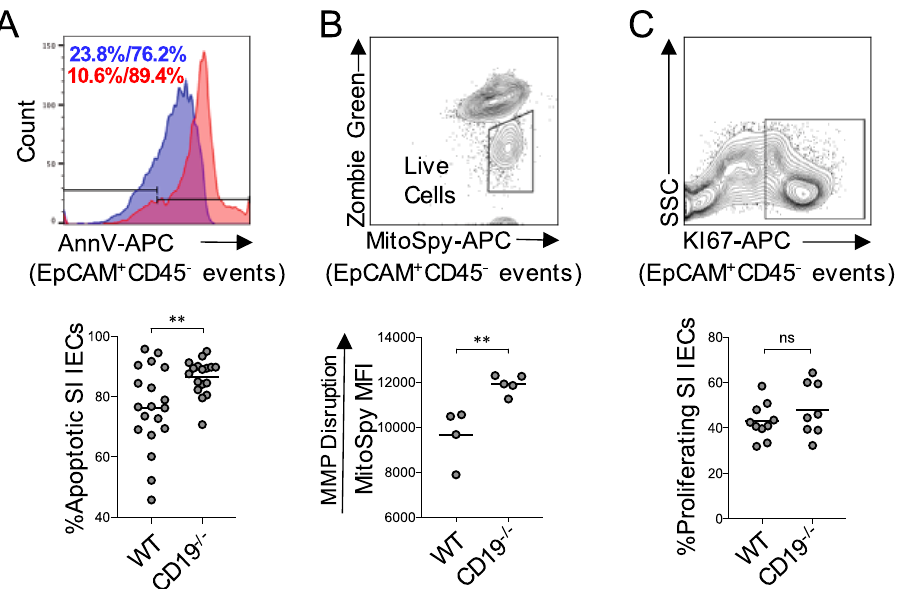
Fig. 3 SI enteropathy is associated with increased IEC apoptosis in CD19 − / − mice. A Representative fl ow cytometry plot demonstrating gating on apoptotic IECs (EpCAM + CD45 − PI − AnnV + ) and the percentage of apoptotic IECs in WT and CD19 − / − mice are shown. Two-tailed unpaired Student ’ s t-test; ** = p = 0.007. Data representative of three replicate experiments. B Representative fl ow cytometry plot demonstrating gating on live IECs (EpCAM + CD45 − ZombieGreen − ) and MitoSpy MFI values in live IECs in WT and CD19 − / − mice are shown. Two-tailed unpaired Student ’ s t-test; ** = p = 0.006. Data representative of two replicate experiments. C Representative fl ow cytometry plot demonstrating gating on proliferating IECs (EpCAM + CD45 − Ki67 + ) and the percentage of proliferating IECs in WT and CD19 − / − mice are shown. Two-tailed unpaired Student ’ s t-test; ns = non-signi fi cant = p = 0.28. Data representative of three replicate